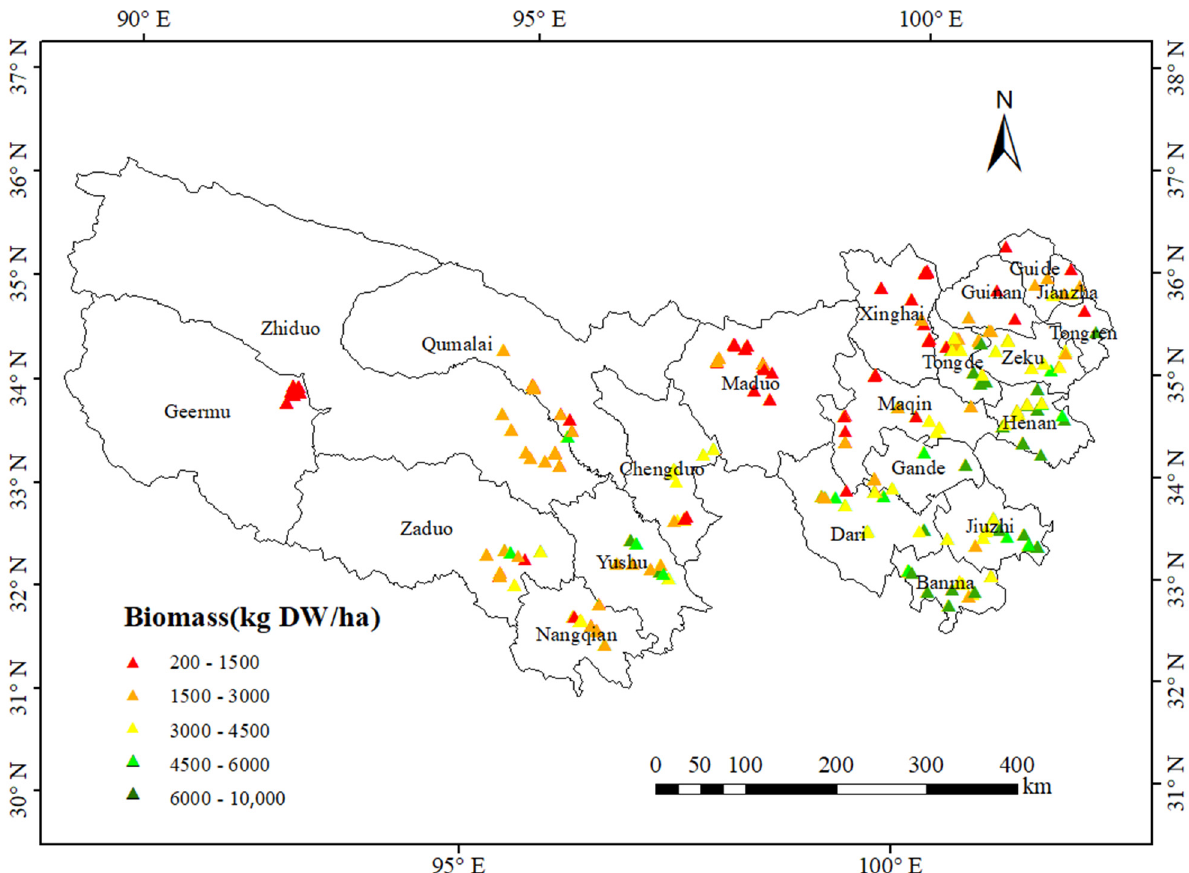
Figure 2. Grassland AGB measured from 2005 to 2015 ( n = 1620) (all AGB values measured at each observation sample station are averaged for that observation station).